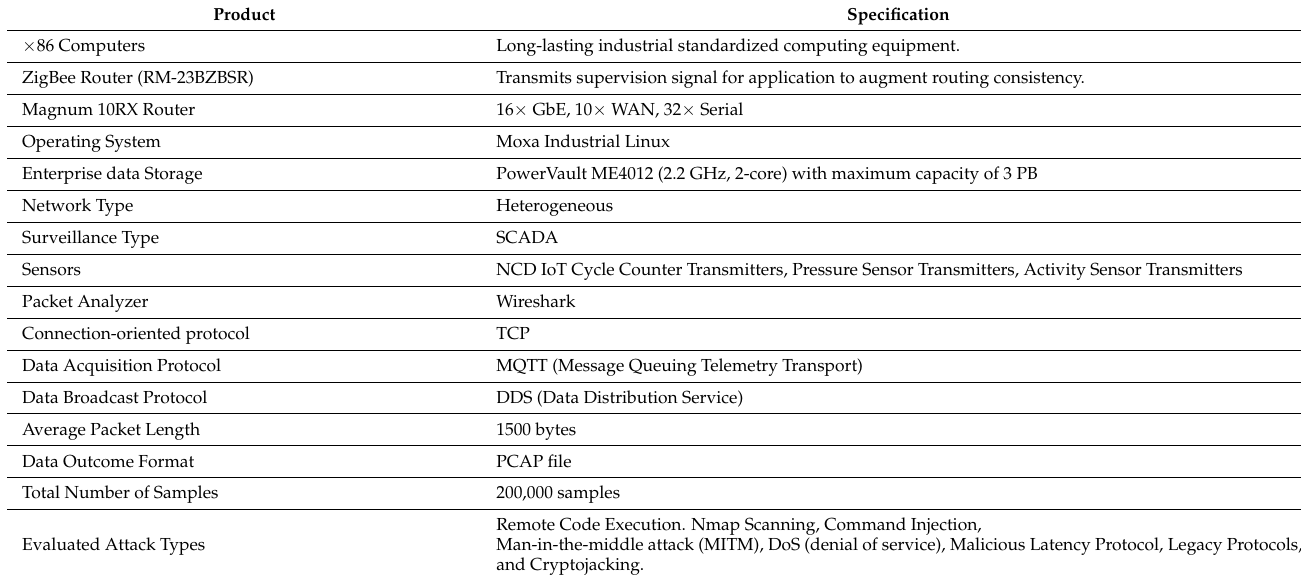
Table 5. Evaluation Environment.